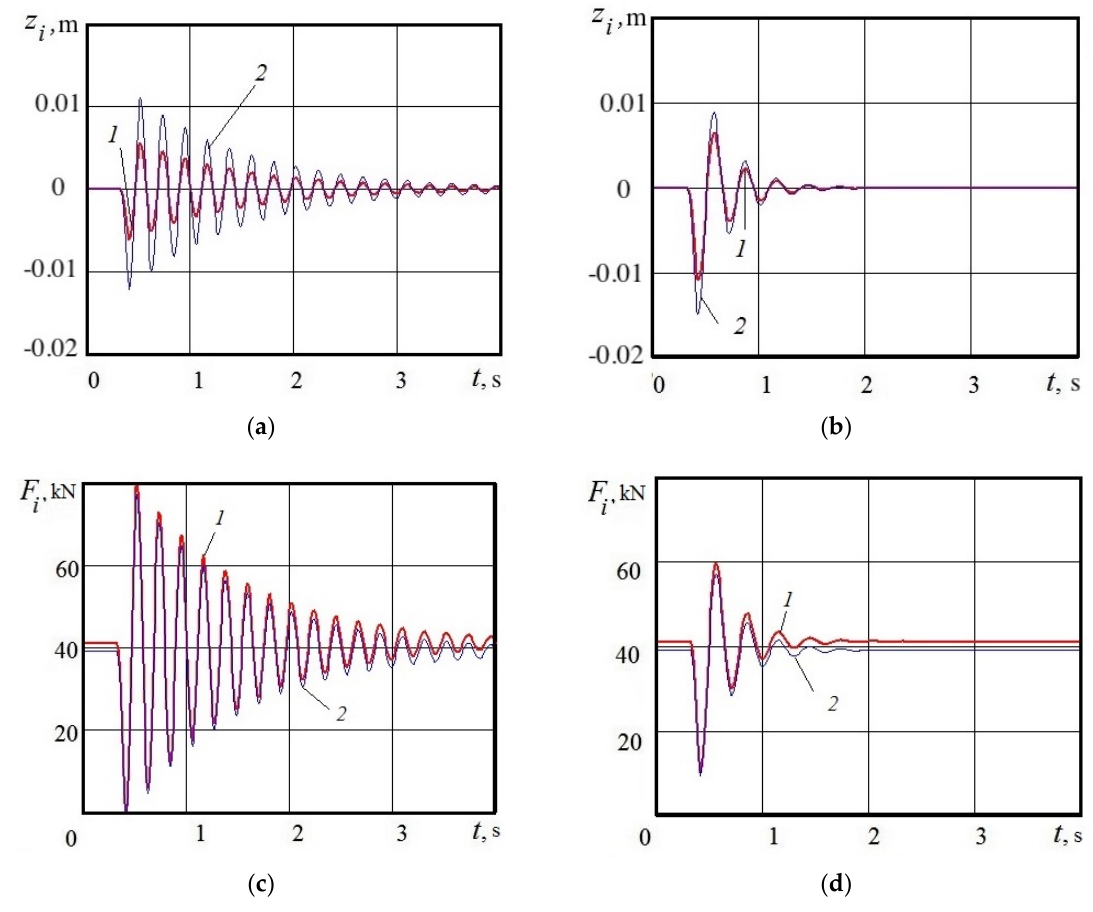
Figure 7. Function graphs: 1 − z 1 = f ( t ), 2 − z 2 = f ( t ), 3 − F 1 = f ( t ), 4 − F 2 = f ( t ); ( a , c ) − C 1 = C 2 = 7000 kN/ м , b 1 = b 2 = 15 kN·s/m; ( b , d ) − C 1 = 2600 kN/m, C 2 = 7000 kN/m, b 1 = 50 kN·s/m, b 2 = 15 kN·s/m.